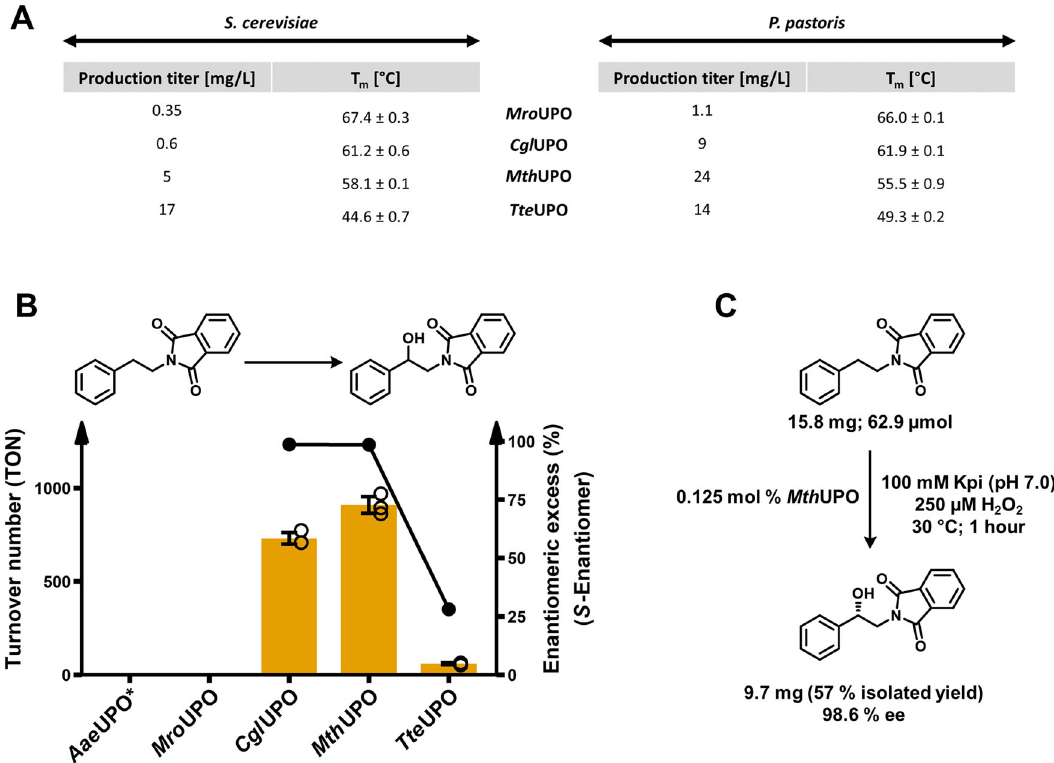
Fig. 5 Expression yields and thermostabilities of UPOs derived from the different yeast systems and conversion of a phenethylamine derivative on analytical and preparative scale. A Comparison of volumetric production titre of recombinant UPOs in shake fl ask scale (1 L) between S. cerevisiae (episomal construct) and P. pastoris (integrative construct) as obtained after ultra fi ltration of the respective culture supernatant. UPOs were produced and secreted utilising their natural signal peptide ( Mro UPO and Cgl UPO) or a previously identi fi ed suitable exogenous signal peptide Mth UPO ( Sce - α Galactosidase) and TteUPO ( S. cerevisiae : Cci -UPO; P. pastoris : Sce -Prepro). For all P. pastoris production setups the methanol inducible promoter P CAT1